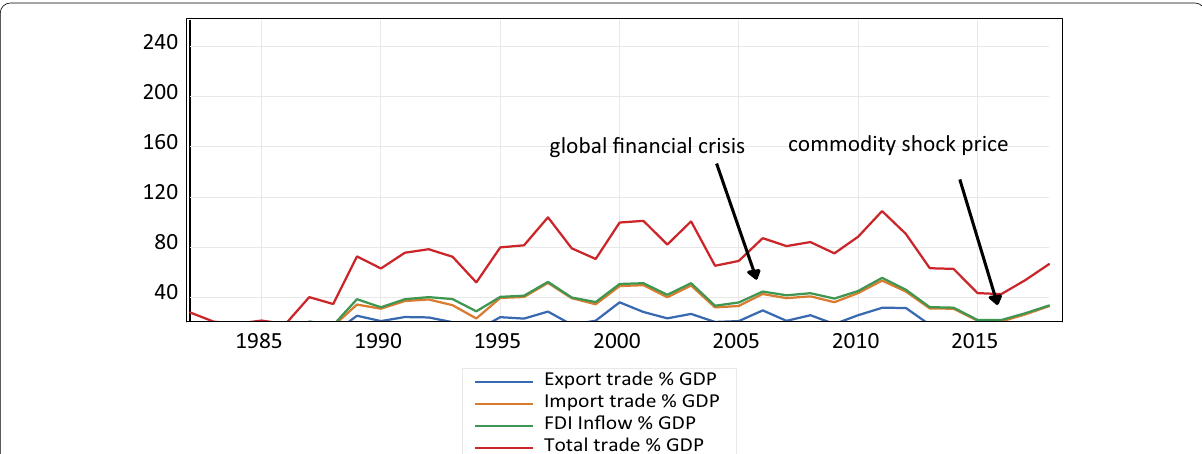
Fig. 1 Time evolution of export trade % GDP, import trade % GDP, FDI inflow % GDP, total trade% GDP indicating the global economic crisis (2007, 2008) and commodity shock price 2016. Sources: author’s